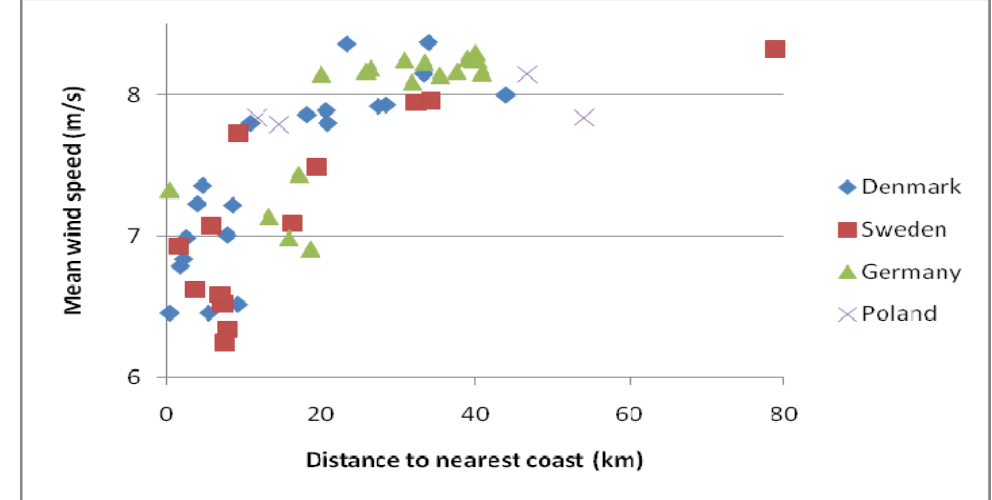
Figure 11. Mean wind speed from Envisat ASAR observations at existing and planned wind farm sites per country in the Baltic Sea study area ( cf. Table A1).